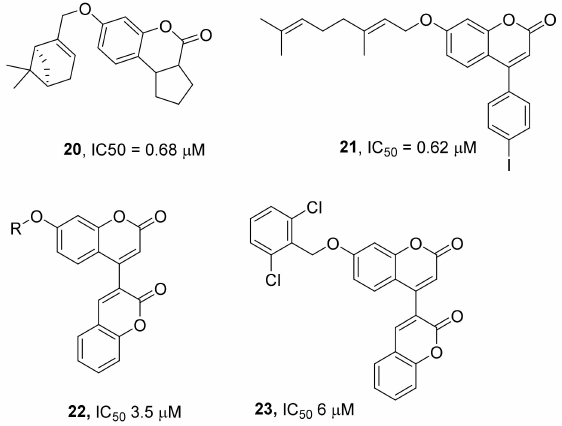
Figure 7. Coumarin derivatives as inhibitors of